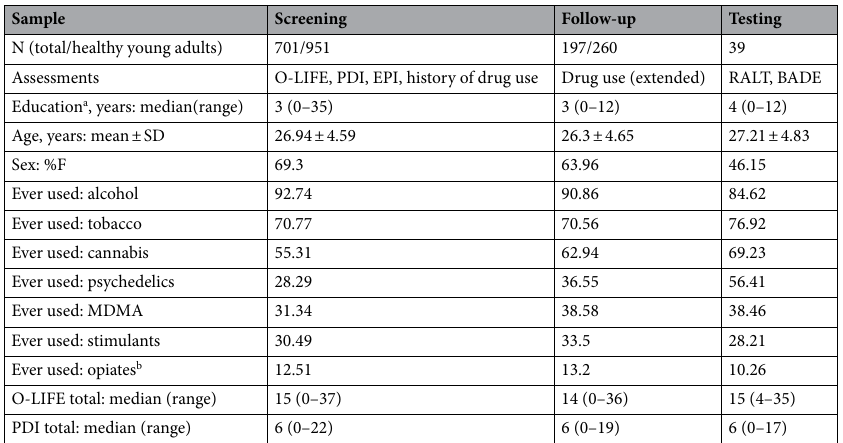
Table 1. Study samples. Sample overview, descriptive statistics characterize population that provided necessary demographic data and met study criteria. O-LIFE 43-item Oxford-Liverpool Inventory of Feelings and Experiences, PDI+ extended 21-item Peters Delusion Inventory, which also includes 5 additional questions (items 24, 33, 34, 41 and 42) pertaining to unusual experiences from CAPE-42 (Community Assessment of Psychic Experience), EPI – Ego Pathology Inventory (not used in the present study), RALT – reversal aversive learning task, BADE Bias Against Disconfirmatory Evidence. a Post high school; b including non-recreational